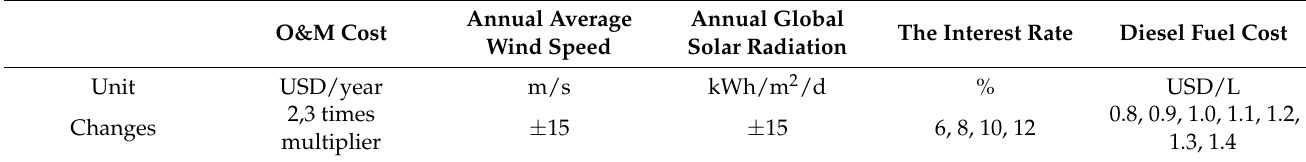
Table 5. Summary of component and resource sensitivity variables used in the